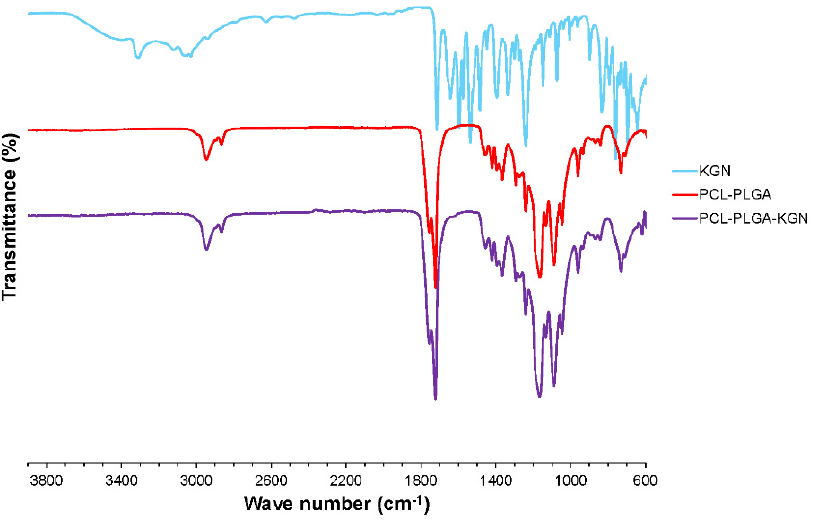
Figure 3. FTIR spectra of pure KGN (powdered form), PCL-PLGA blend (electrospun mesh), and PCL-PLGA-KGN composite (electrospun mesh).